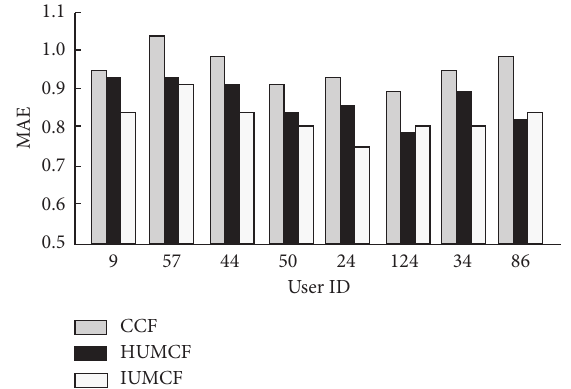
Figure 6: Comparison of MAE results under different users with the same number of